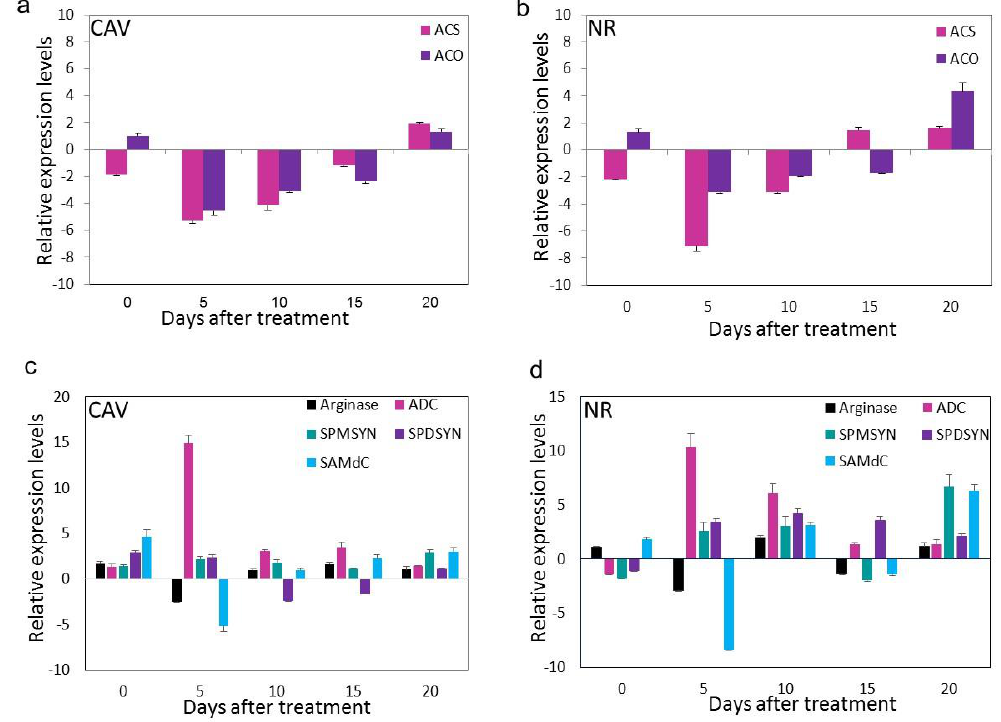
Figure 6. Relative expression of ethylene pathway [1-aminocyclopropane-1-carboxylic acid synthase ( ACS ) and 1-aminocyclopropane-1-carboxylic acid oxidase ( ACO )] and polyamine pathway (Arginase, Arginine decarboxylase ( ADC ), Spermidine synthase ( SPDSYN ), Spermine synthase ( SPMSYN ), and S-adenosylmethionine decarboxylase ( SAMdC ) as determined by qRT-PCR in sodium nitroprusside (SNP) treated fruits of Nanjanagudu rasabale (NR, AAB genome) and Cavendish (CAV, AAA genome) banana fruits in di ff erent days after treatment with SNP. ( a ) E ff ect of SNP on expression of ethylene pathway genes, ACS and ACO in CAV fruit pulp; ( b ) E ff ect of SNP on expression of ethylene pathway genes, ACS and ACO in NR fruit pulp; ( c ) E ff ect of SNP on expression of polyamine pathway genes, SAMdC , Arginase , SPDSYN , SPMSYN , and ADC in CAV fruit pulp; ( d ) E ff ect of SNP on expression of polyamine pathway genes, SAMdC , Arginase , SPDSYN , SPMSYN , and ADC in NR fruit